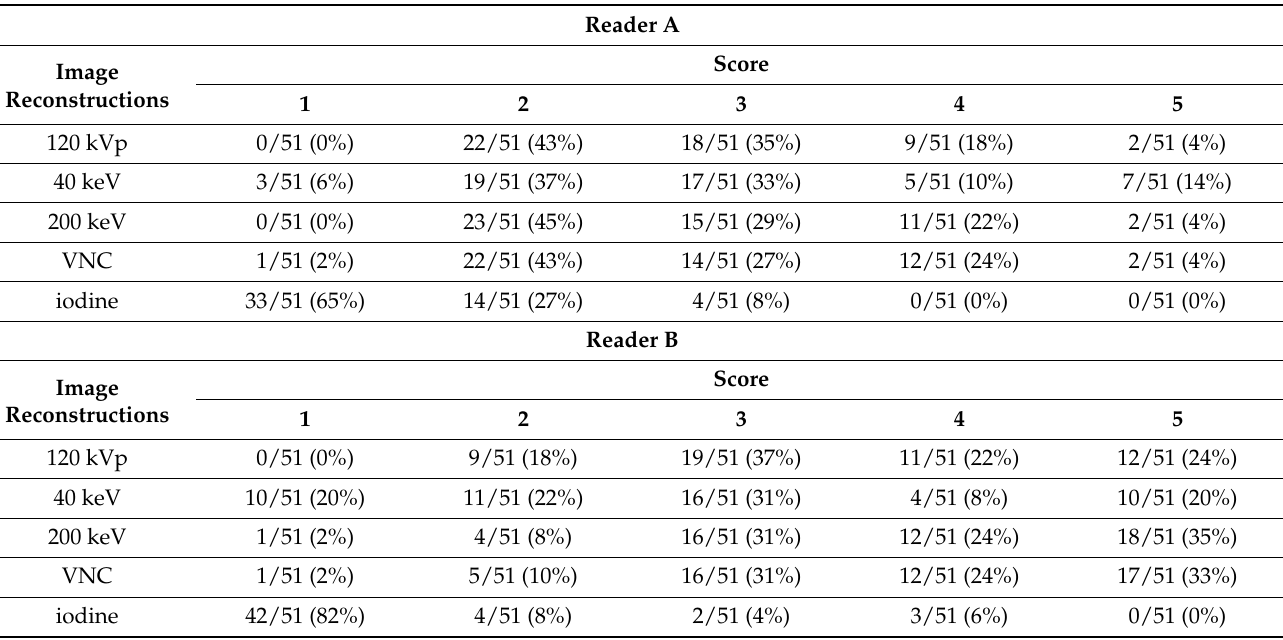
Table 1. Qualitative score of peristalsis-related streak artifact severity on the liver of Reader A and B in conventional 120 kVp images, 40 keV monoenergetic images, 200 keV monoenergetic images, virtual non-contrast (VNC) images, and iodine